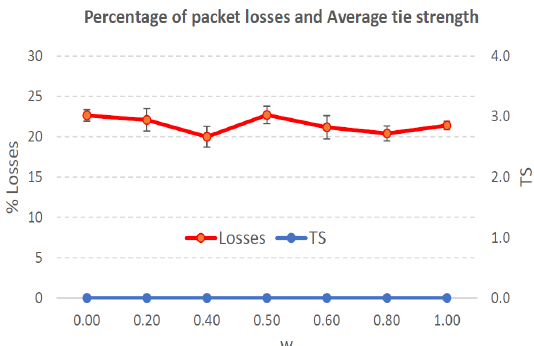
Figure 4. Percentage of packet losses and average tie strength of the forwarding path. Scenario with very low social media interaction (tie strength (TS) normal distribution with µ = 1 and σ = 1). Nodes’ density = 100 nodes/km 2